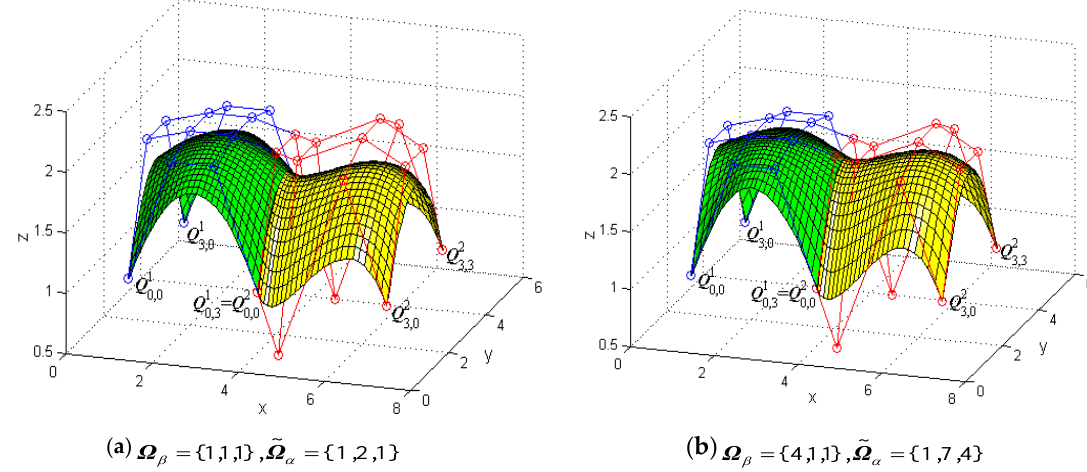
Figure 9. Generalized bicubic H-Bézier surfaces with G 1 continuity in the u and v directions.